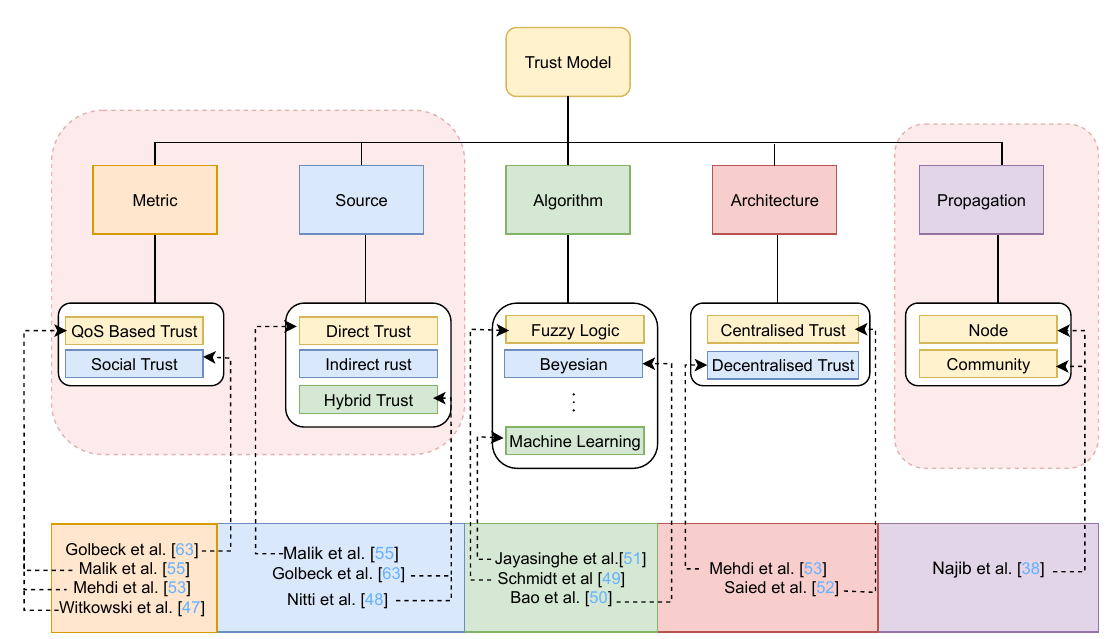
Figure 6. Components of a trust model within